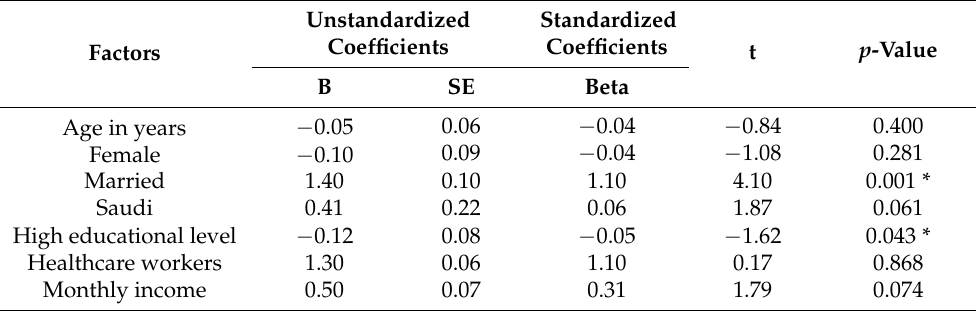
Table 3. Multiple linear regression model for determinants of consumers’ knowledge regarding potential harms of foods sold by the food